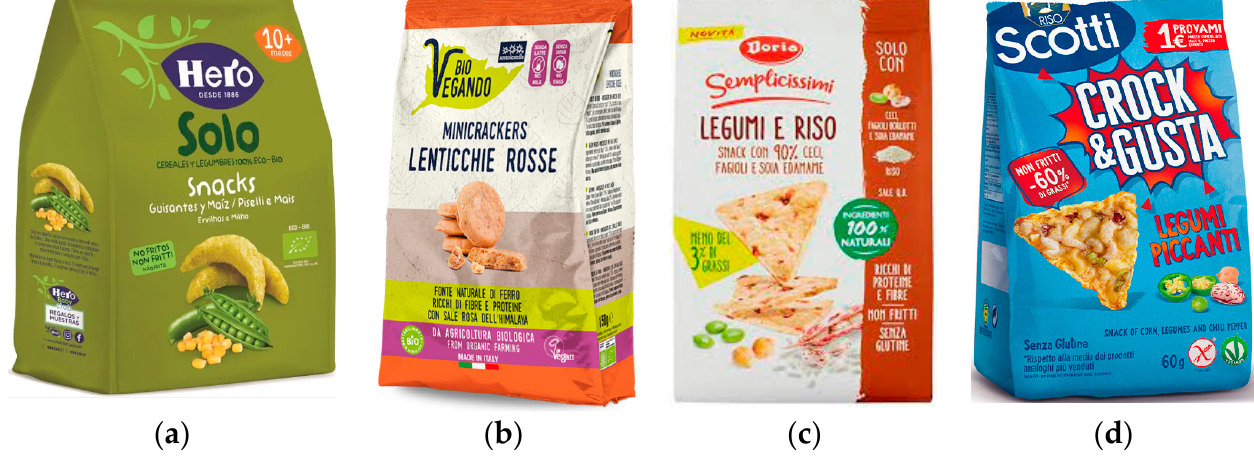
Figure 1. Samples of Italian ready-to-eat snacks. ( a ) Mix of cereals and legumes snack (on the label, we can observe the following main claims: organic, non-fried); ( b ) red lentils snack (on the label, we can observe the following main claims: bio, vegan, natural source of fibers, rich in proteins and fibers, with Himalaya red salt); ( c ) mix of legumes and rice snack (on the label, we can observe the following main claims: snack with 90% chickpeas, beams, edamame, less than 3% in fat, rich in proteins and fibers, non-fried, gluten-free); ( d ) mix of corn, legumes and chili pepper (on the label, we can observe the following main claims: hot legumes, gluten-free, non-fried, less than 60% in fat). Source: photos provided by the co-author Antonella Labbate, 2022.